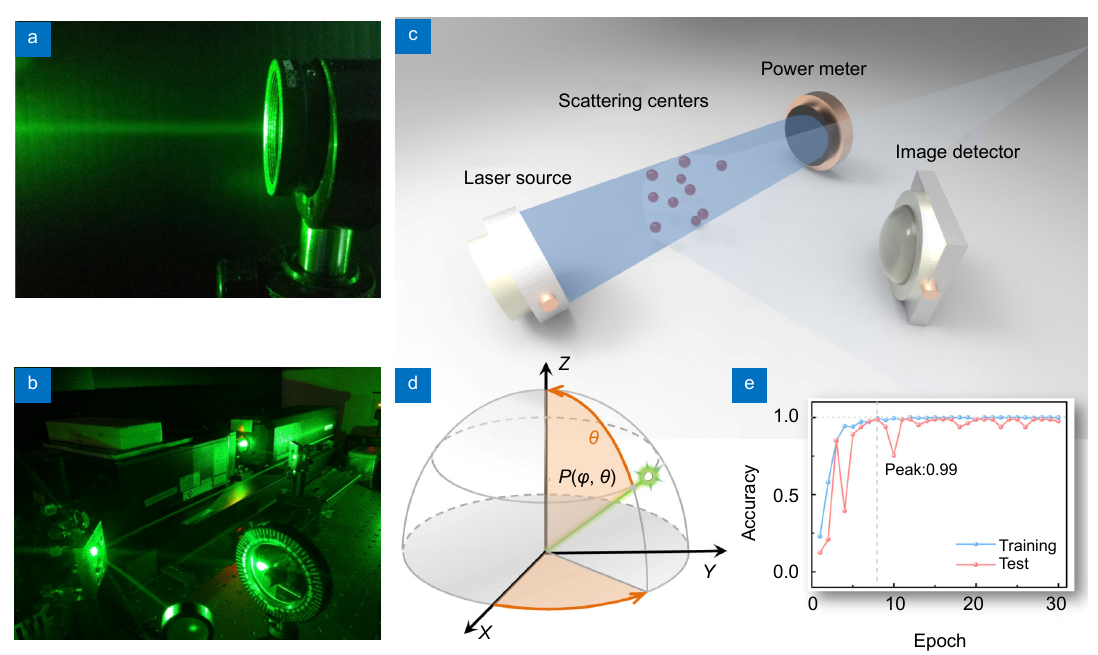
Fig. 1 | Mechanisms to detect information from scattered photon. Optical images of ( a ) Rayleigh scattering by small molecules, and ( b ) scattering at the interfaces between air and reflective surfaces. Laser: 532 nm, CW laser. ( c ) Schematic of the setup to analyze the scattered photon from the laser beam. Power meter is the conventional instrument used for the calibration and training data collection. ( d ) Diagram showing the detection of the direction of the incident laser beam. Data presented in the spherical coordinates with the green line that denotes the incident laser (polar angle denoted by θ and azimuthal angle φ ). ( e ) Experimental results to show the accuracy of the CNN DL to measure the intensity of the incident laser after every training epoch. Blue curve denotes the accuracy of the model to measure the training data and red curve denotes the accuracy to measure the independent testing data different from the training data. The accuracy of the model is defined as the peak value as 0.99 on the test data curve.